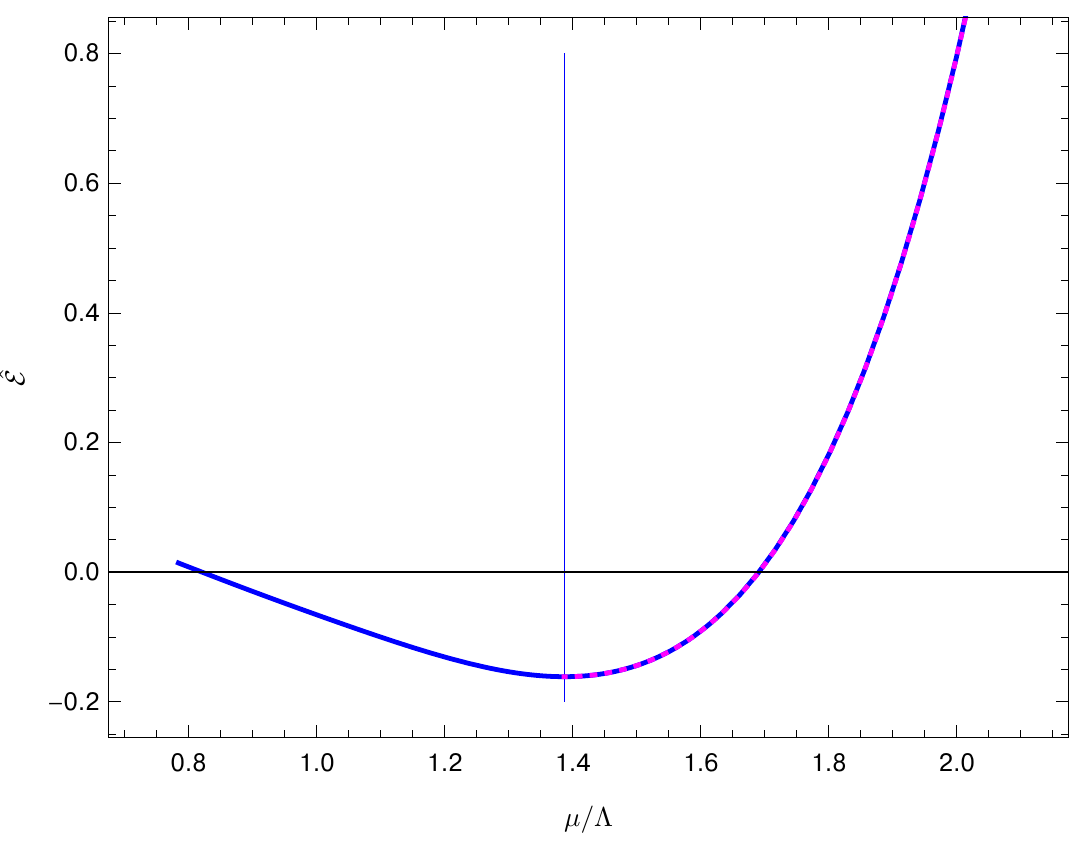
s vacua energy in the two different computational A V